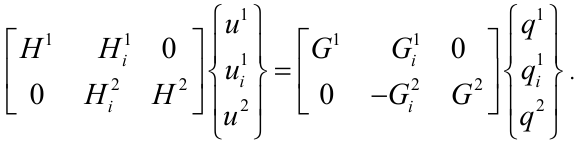
The threshold chloride content for reinforcement depassivation is 0.10% of the concrete weight [13]. Figure 3 shows the results achieved by BEM, whose time was discretised within 20 time steps and the space kernels were integrated by 10 integration points, and the reference